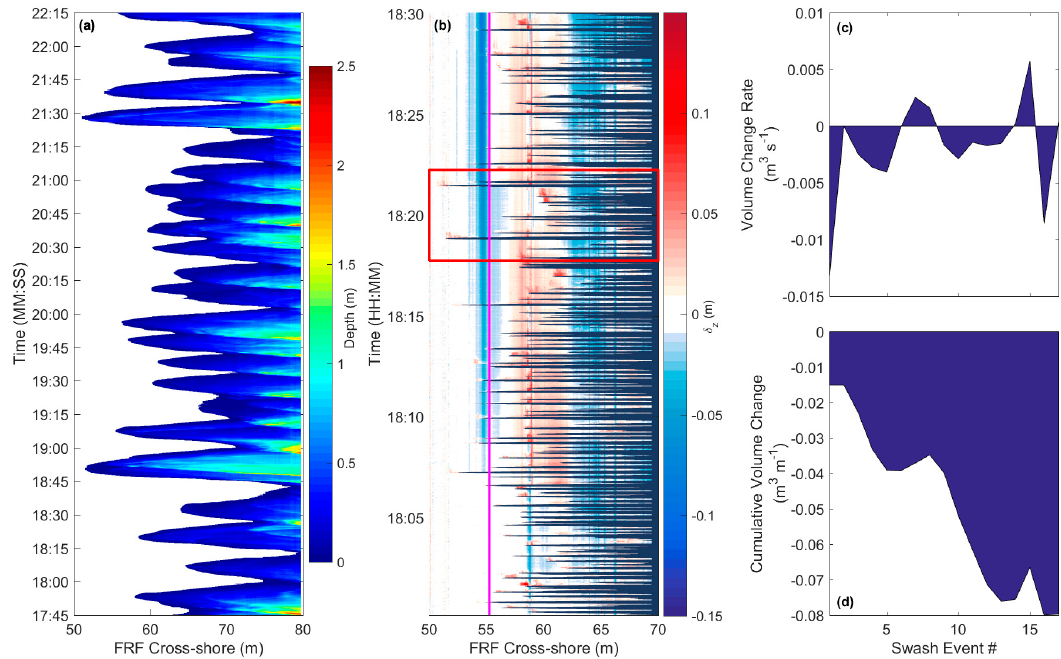
Figure 11. ( a ) Swash depth through time versus cross-shore location starting at 4 October 2015 18:17:45 UTC (corresponding to the time period outlined in red in the center panel) and ( b ) elevation changes since 4 October 2015 18:00:00 UTC at a fixed alongshore location ( y = 945 m). The magenta line indicates the cross-shore position of the dune toe and the dark blue horizontal lines indicate times when the foreshore is underwater. ( c ) Sediment flux into or out of the dune for each of the 17 swash events, and ( d ) the cumulative volume change above the dune toe for each swash event.